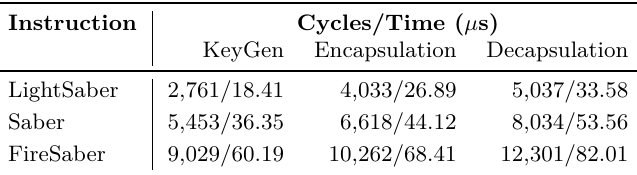
Table 3: Execution times for different variants of Saber using Vivado simulation. Time is calculated at 150 MHz. The polynomial multiplier uses 256 MAC units in parallel. Instruction Cycles/Time ( µ